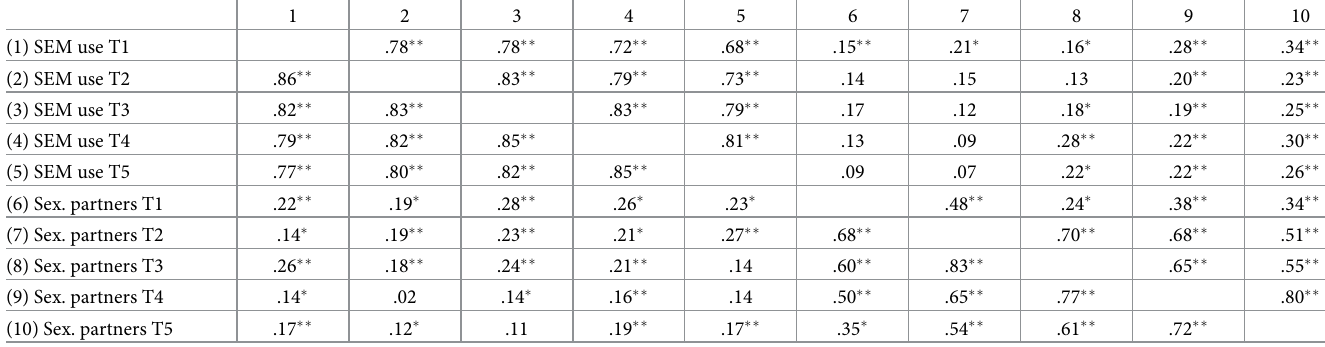
SEM and condom use (H2) In the Rijeka panel, we observed no significant association between adolescents’ frequency of SEM use and condom use at most recent sexual intercourse either in the predictor-only model, or the model with the controls included (Table 5). Gender did not moderate this associ- ation. Findings in the Zagreb panel fully replicated the results from the Rijeka panel. Table 2. Cross-correlations between SEM use and the number of sexual partners by wave and panel sample. 1